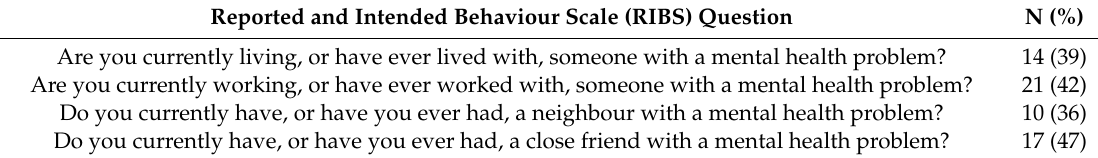
Table 3. Forms of Prior Contact with Mental